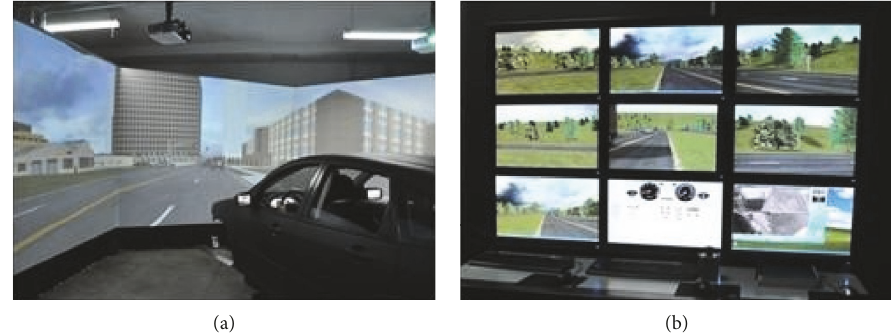
Figure 3: Illustration of BJTU driving simulator system. (a) Driving simulator; (b) monitoring and controlling